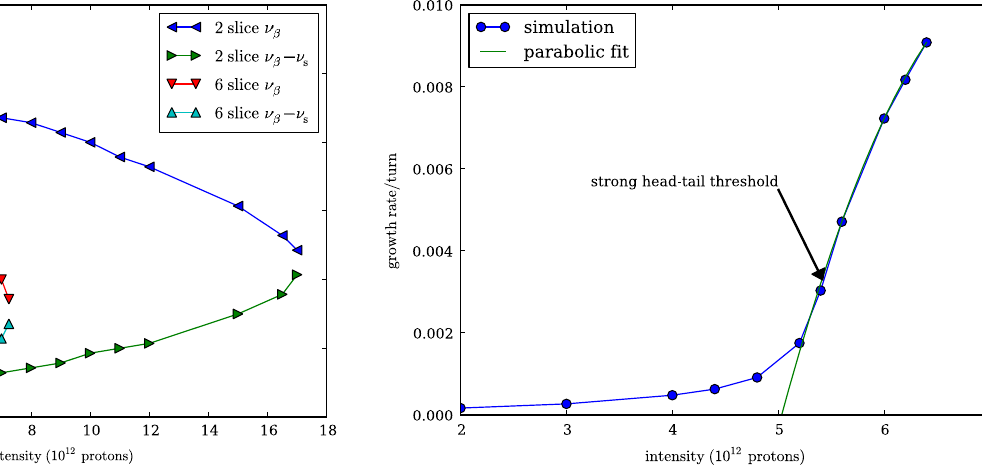
FIG. 5. (Color) The growth rate of dipole motion in the simu- lated accelerator is shown as a function of beam intensity. A parabolic fit is superimposed at the intensity where the strong head-tail threshold is